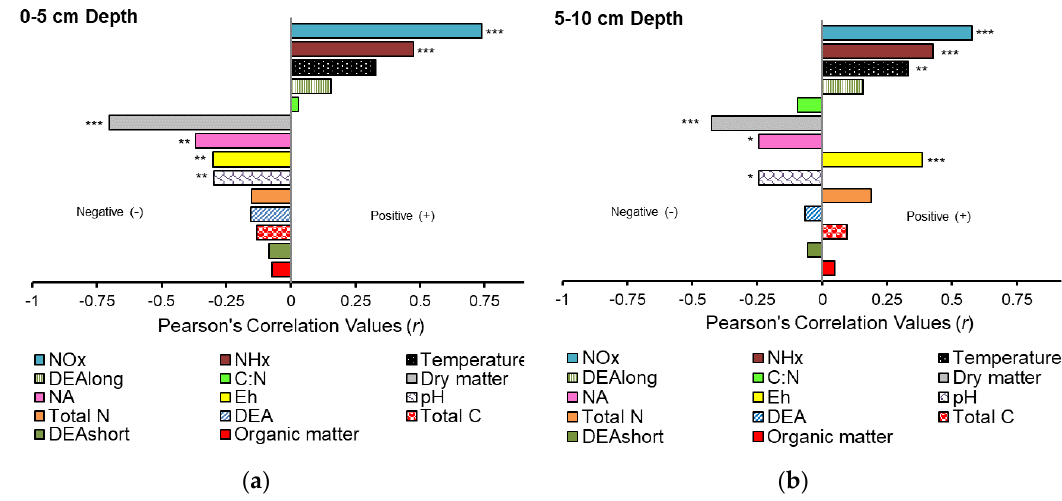
Figure 6. Pearson correlation coefficients ( r values) of measured variables against nitrous oxide (N 2 O) emissions at ( a ) 0 – 5 cm depth and ( b ) 5 – 10 cm depth. Bars to the right of the y – axis indicate a positive ( + ) relationship and bars to the left are negatively ( − ) correlated. Asterisks indicate significant relationships at * p ≤ 0.05, ** p ≤ 0.01, *** p ≤ 0.001.